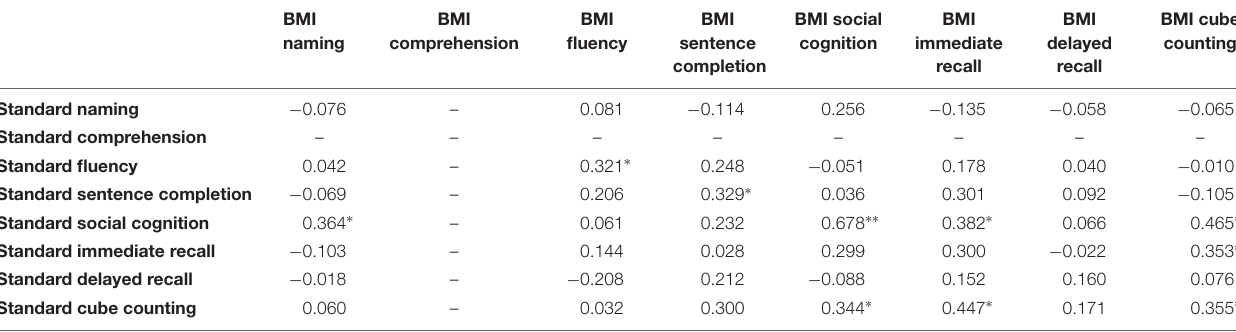
TABLE 2 | Congruency of Standard paper and pencil ECAS version and BMI adapted ECAS